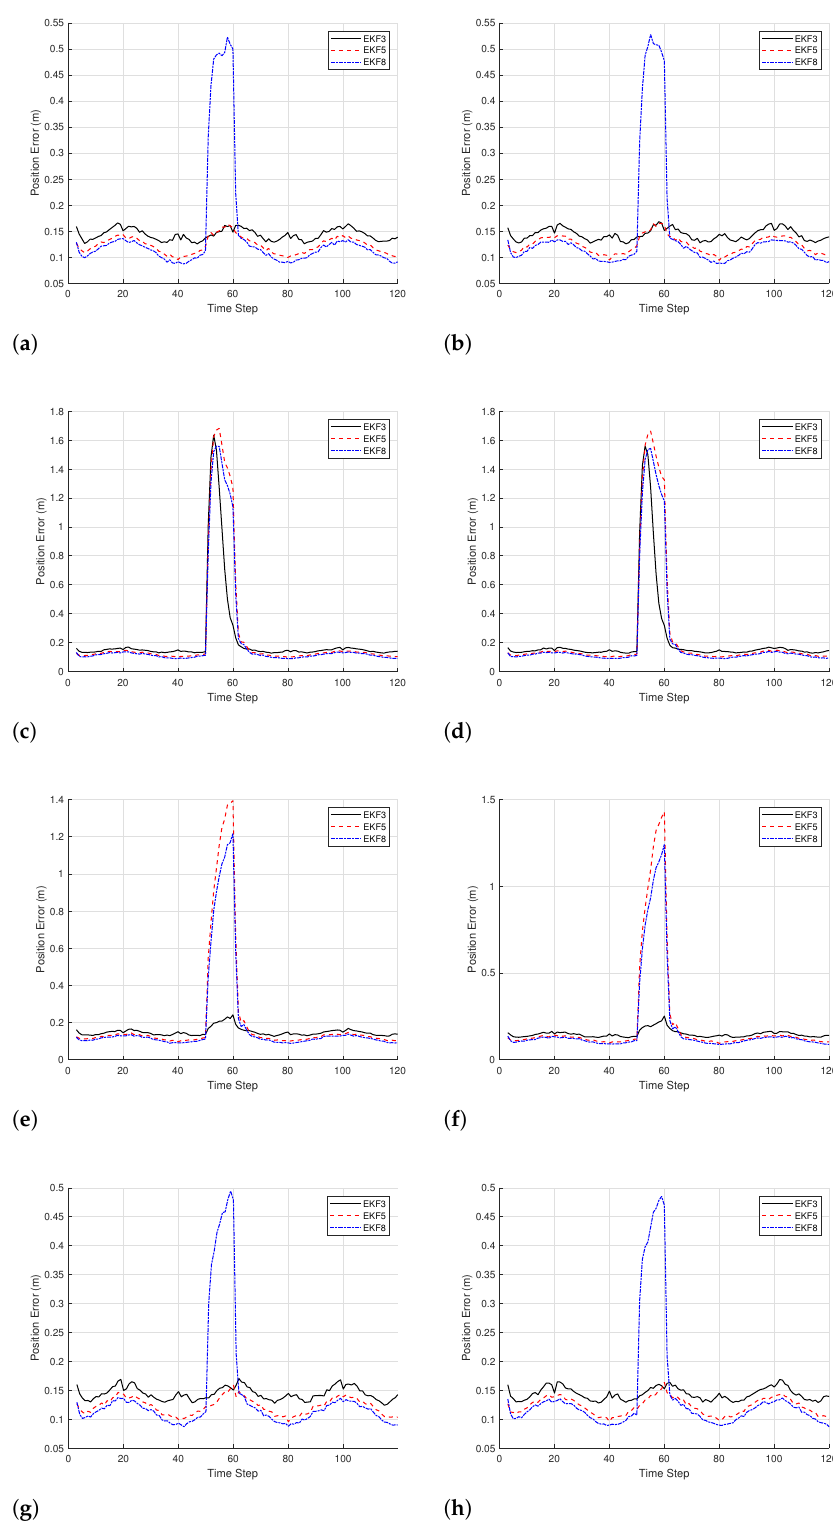
Figure 4. RMS position errors of EKF-based localization under temporary NLOS conditions in which the transmitter (FN) in a NLOS was ( a ) FN1, ( b ) FN2, ( c ) FN3, ( d ) FN4, ( e ) FN5, ( f ) FN6, ( g ) FN7, and ( h )